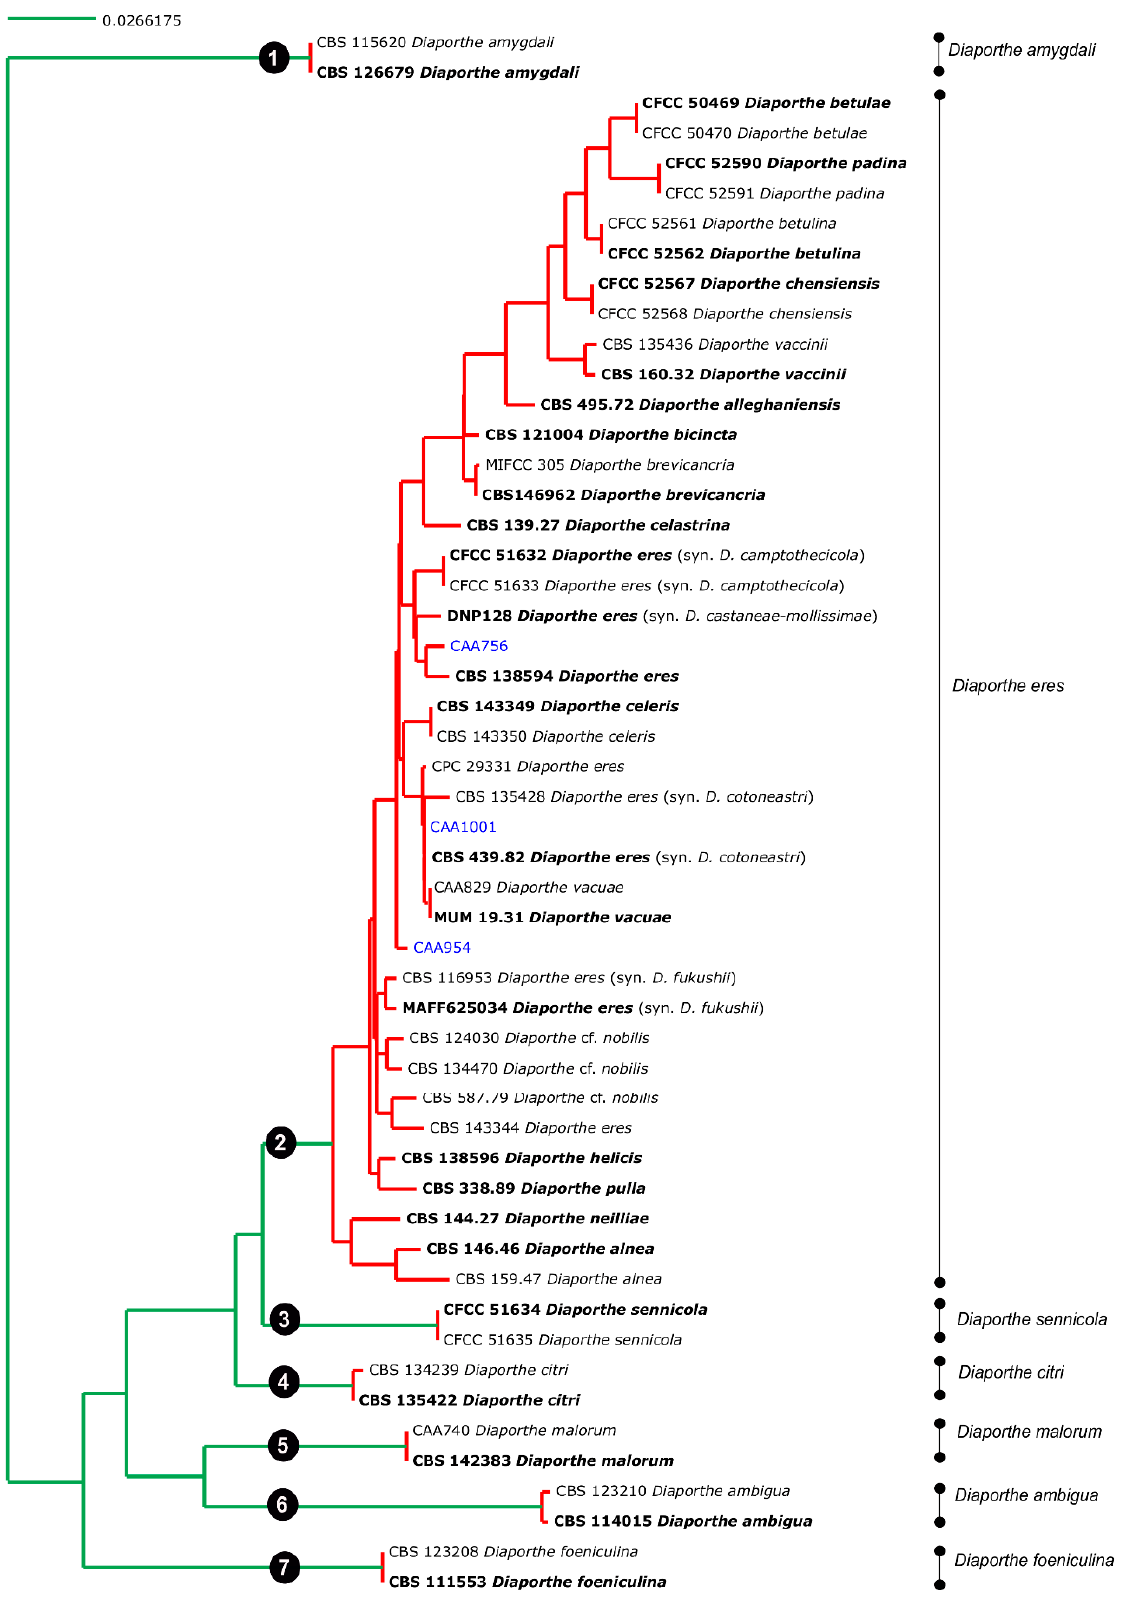
Figure 3. Results of the mPTP analysis for the Diaporthe eres species complex and related taxa. Putative species clusters are indicated using transitions from green-colored to red-colored branches. The isolates obtained in this study are indicated in blue.